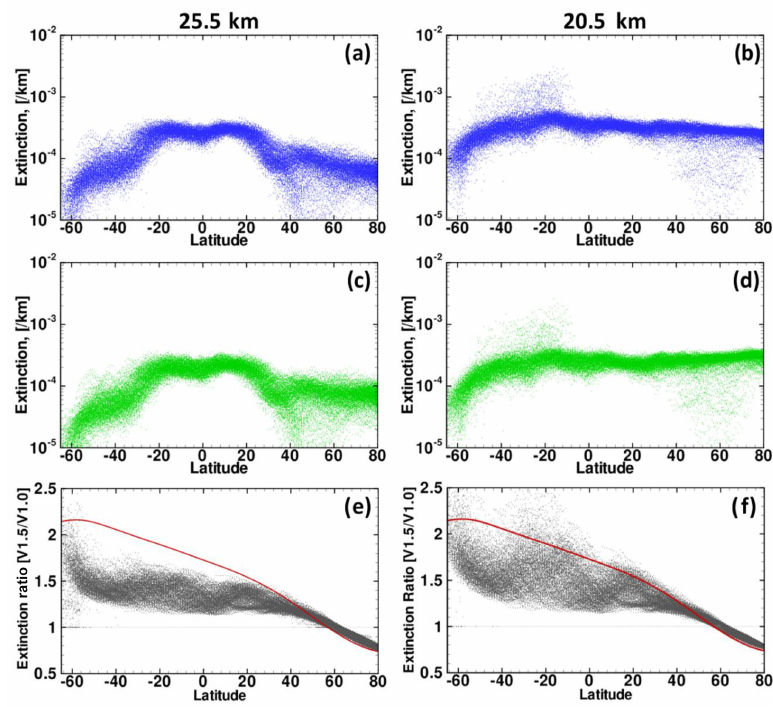
Figure 5. Scatter diagrams of retrieved aerosol extinctions for the V1.5 ASD (blue) and the V1.0 ASD (green) at 25.5km (a, c, e) and 20.5km (b, d, f) for an entire month during the Calbuco period 21 April ∼ 20 May 2015. The black dots in the bottom panel show extinction ratios (V1.5 / V1.0), and the red lines show the inverse of the P((cid:50)) ratio ( P V1 . 0 (cid:50)/P V1 . 5 (cid:50) ). The ratio of extinctions has large variability at a given latitude, though the P((cid:50)) ratios do not. (From Chen et al., 2018.)